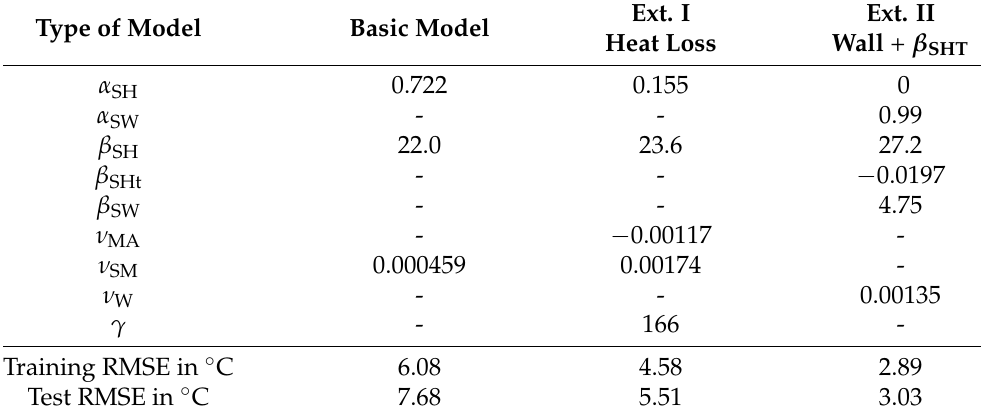
Table 2. Comparison of parameters and prediction accuracy of the three grey-box